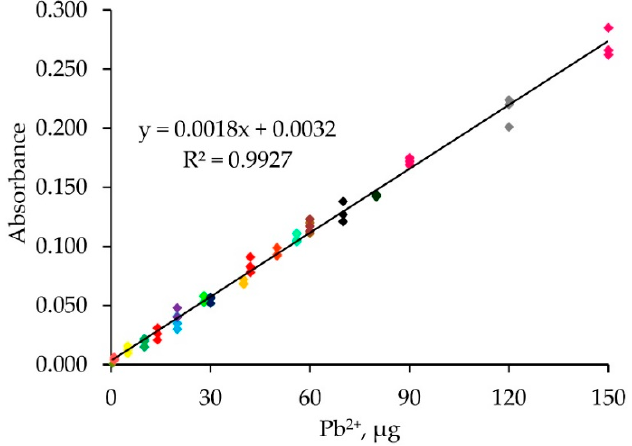
Figure 6. The single standard calibration graph.